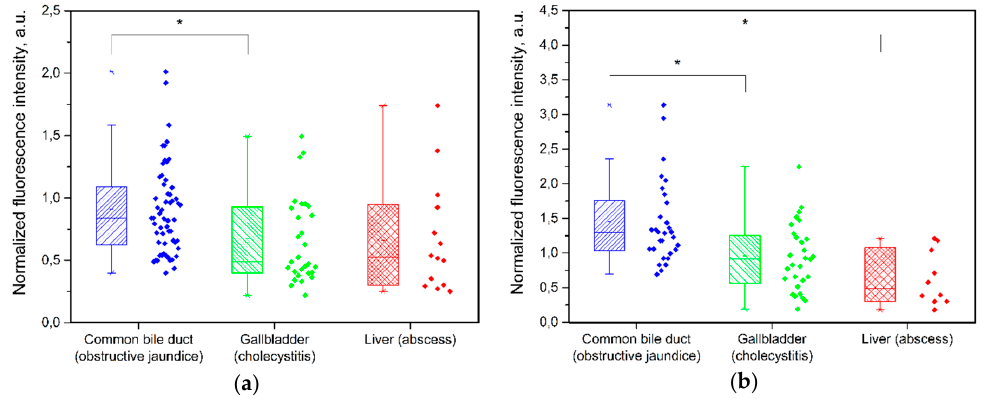
Figure 3. Box-Whisker diagrams of fluorescence intensity maxima under excitation wavelengths 365 nm ( a ) and 450 nm ( b ). * Confirmed statistically significant differences. The level of significance